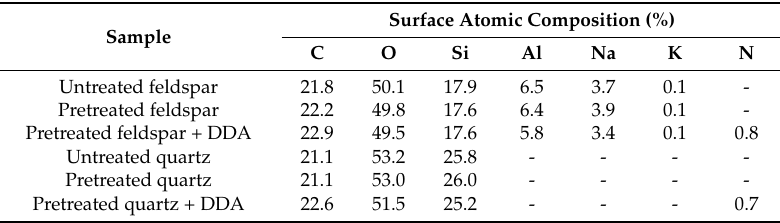
Table 2. Relative content of elements on the surfaces of feldspar and